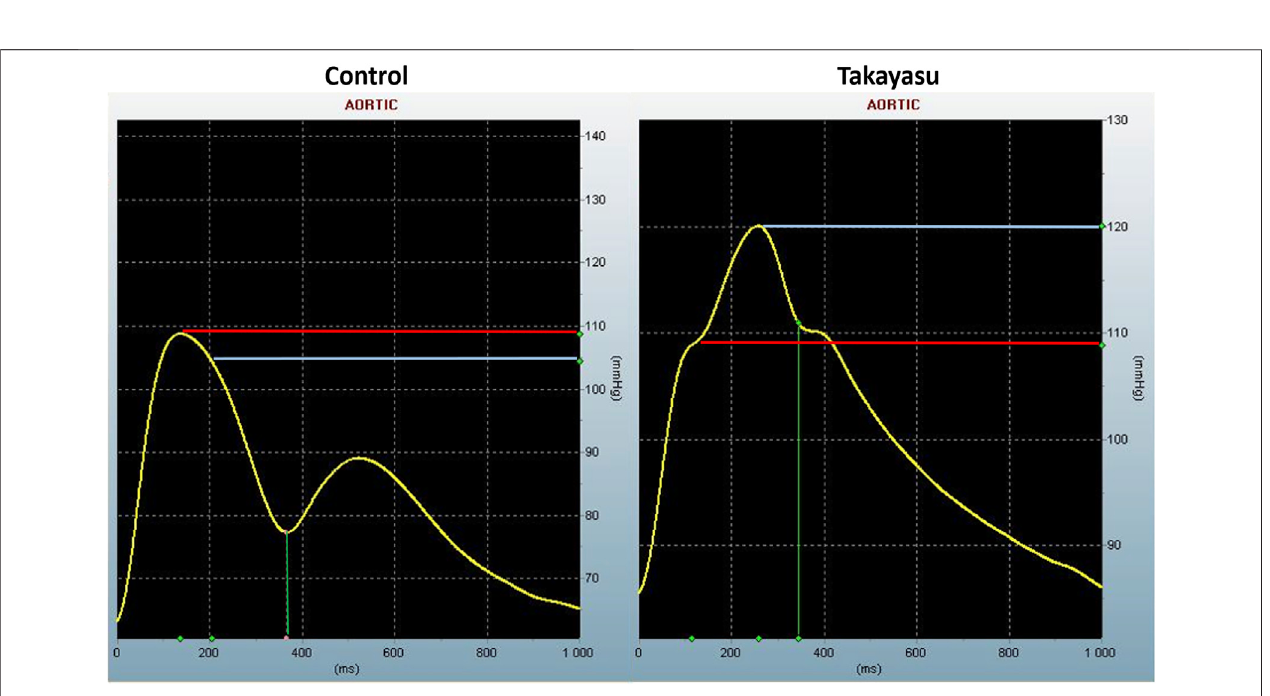
suprasystolic occlusion of the upper arm ending with a 5- minute post-ischemic measurement. After release of the cuff, PORH peak value of oxygen saturation (OxyP) was assessed